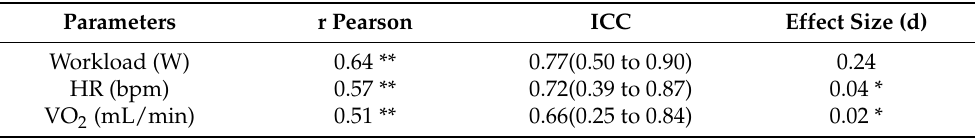
Table 2. Agreement with gold standard (RQA vs. GEx) for Workload (Watt), HR (bpm), and VO 2 (mL/min)